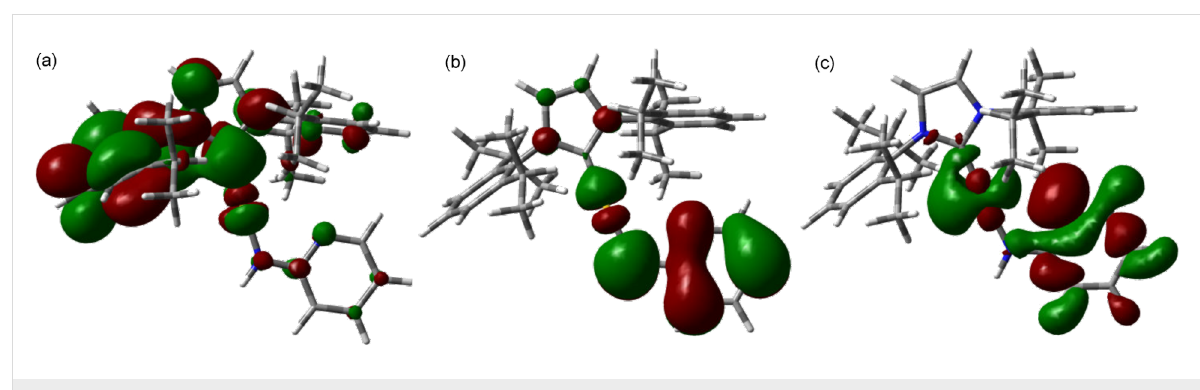
Figure 4: (a) LUMO, (b) HOMO and (c) HOMO-1 of complex 3